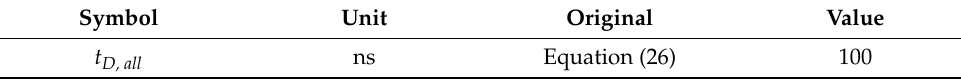
Table 4. Calculation of the charging current with parameters provided in Tables 1–3. Symbol Unit Original Value t D, all